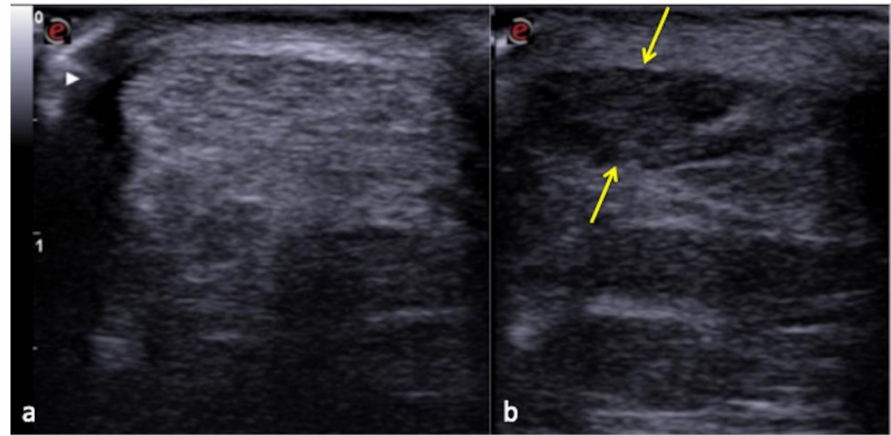
Figure 13. Normal Achilles tendon ( a ) and anisotropy-related artifact seen at the same tendon ( b ) that appears hypoechoic (arrows) due to an incorrect angle of the transducer.